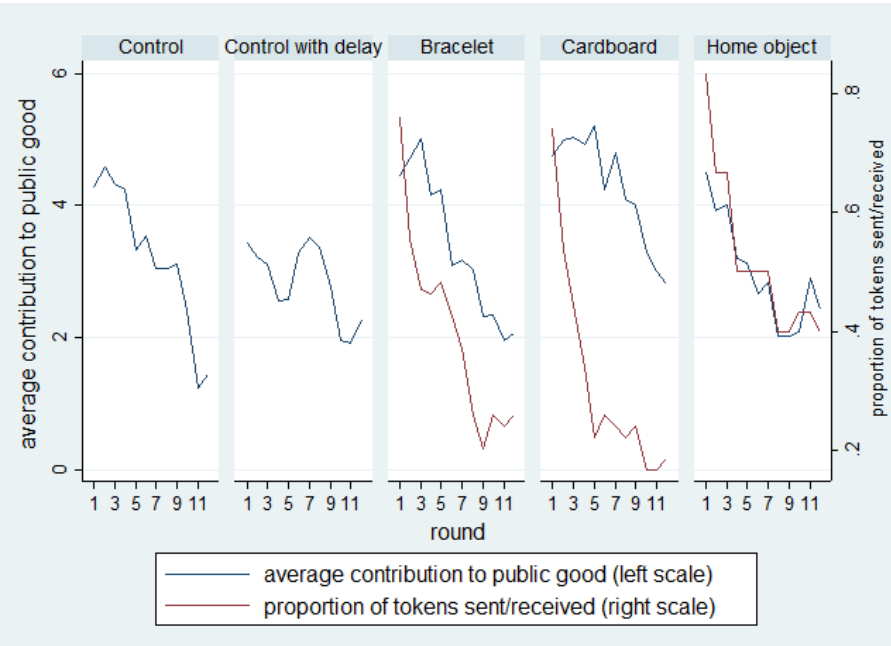
Figure 1. Contributions to the public good and proportion of tokens sent/received in each round .